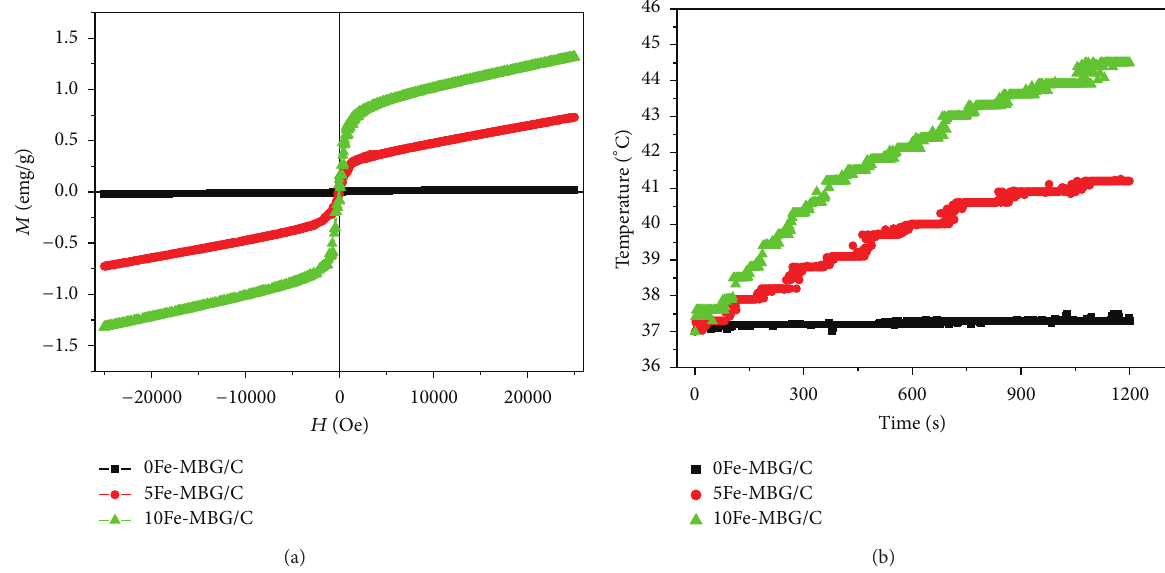
Figure 7: (a) Magnetization curves as a function of the applied magnetic field for different Fe-MBG/C composite scaffolds at room temperature; (b) magnetic heating curves of different Fe-MBG/C composite scaffolds in an alternating magnetic